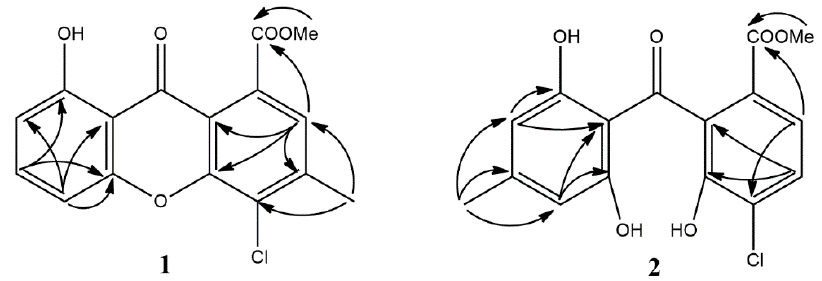
Figure 2. The selected HMBC correlations of compounds 1 and 2 .